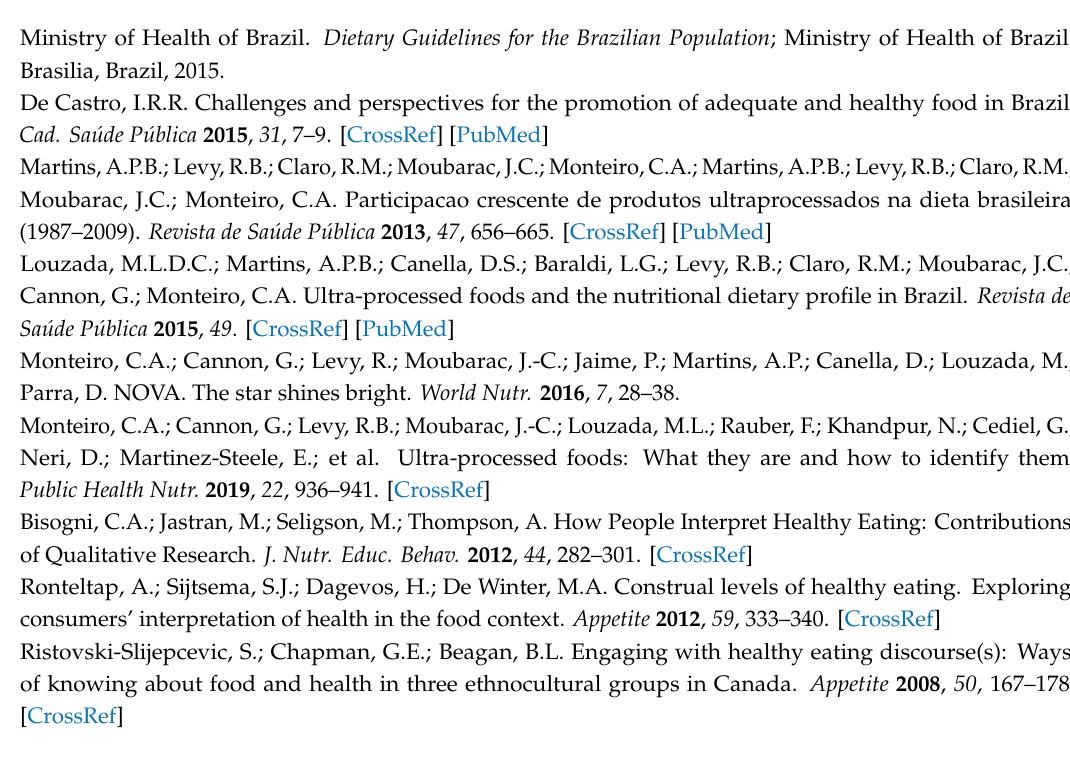
Figure S1. Examples of circulars’ health and wellness sections (page 1); Figure S2. Examples of circulars’ health and wellness sections (page 2); Table S1. NOVA food groups: definition according to the extent and purpose of food processing, and examples; Table S2. Additional Claims (AC) on FoP labels of foods advertised in ‘health and wellness’ sections of supermarket circulars, classified by